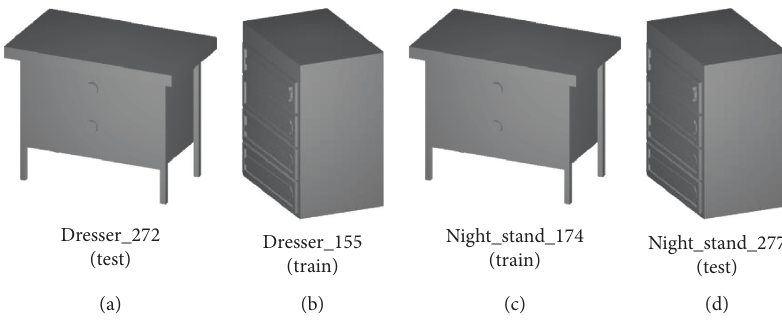
Figure 9: Similar models in different categories.